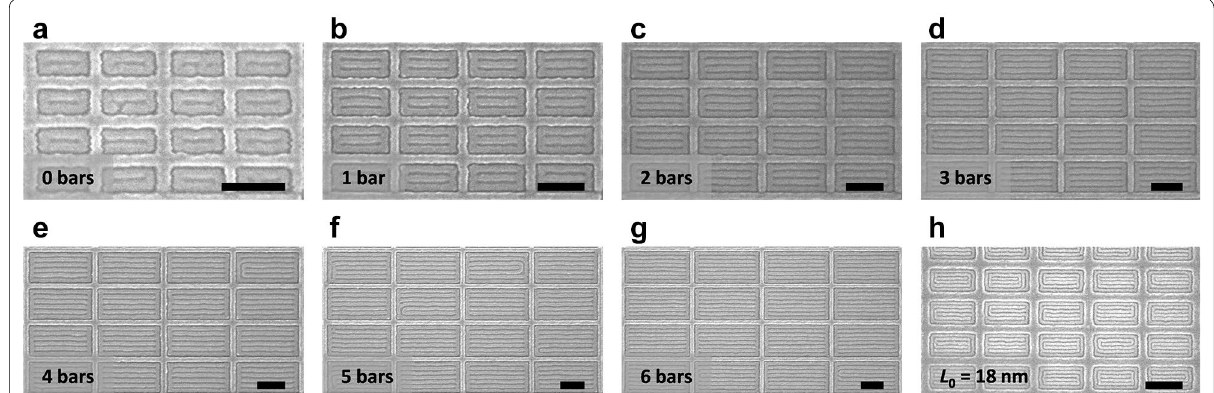
Fig. 5 SEM images of aligned ladder‑shaped block copolymer patterns inside rectangular confinement. Aspect ratio was 2:1. Vertical width of the rectangular confinement was a 2.0 L 0 , b 3.1 L 0 , c 4.1 L 0 , d 5.1 L 0 , e 6.1 L 0 , f 7.0 L 0 , and g 7.9 L 0 for SD45 ( L 0 L 0 18 nm was used. Parallel bars were formed in the horizontal direction (0 state) to minimize the number of T‑junctions. Scale bars, 200 =